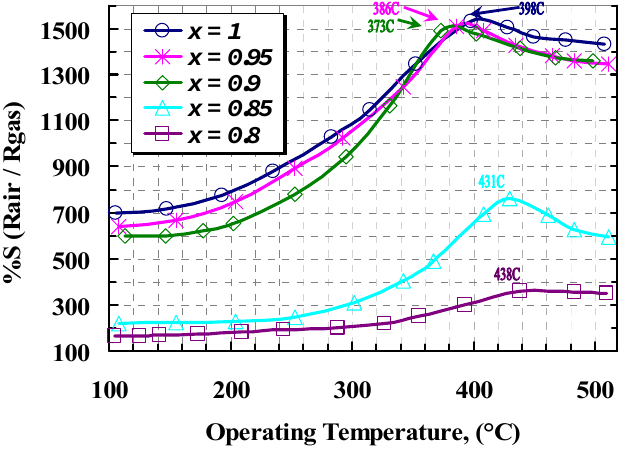
Figure 13. Sensitivity of x WO operating